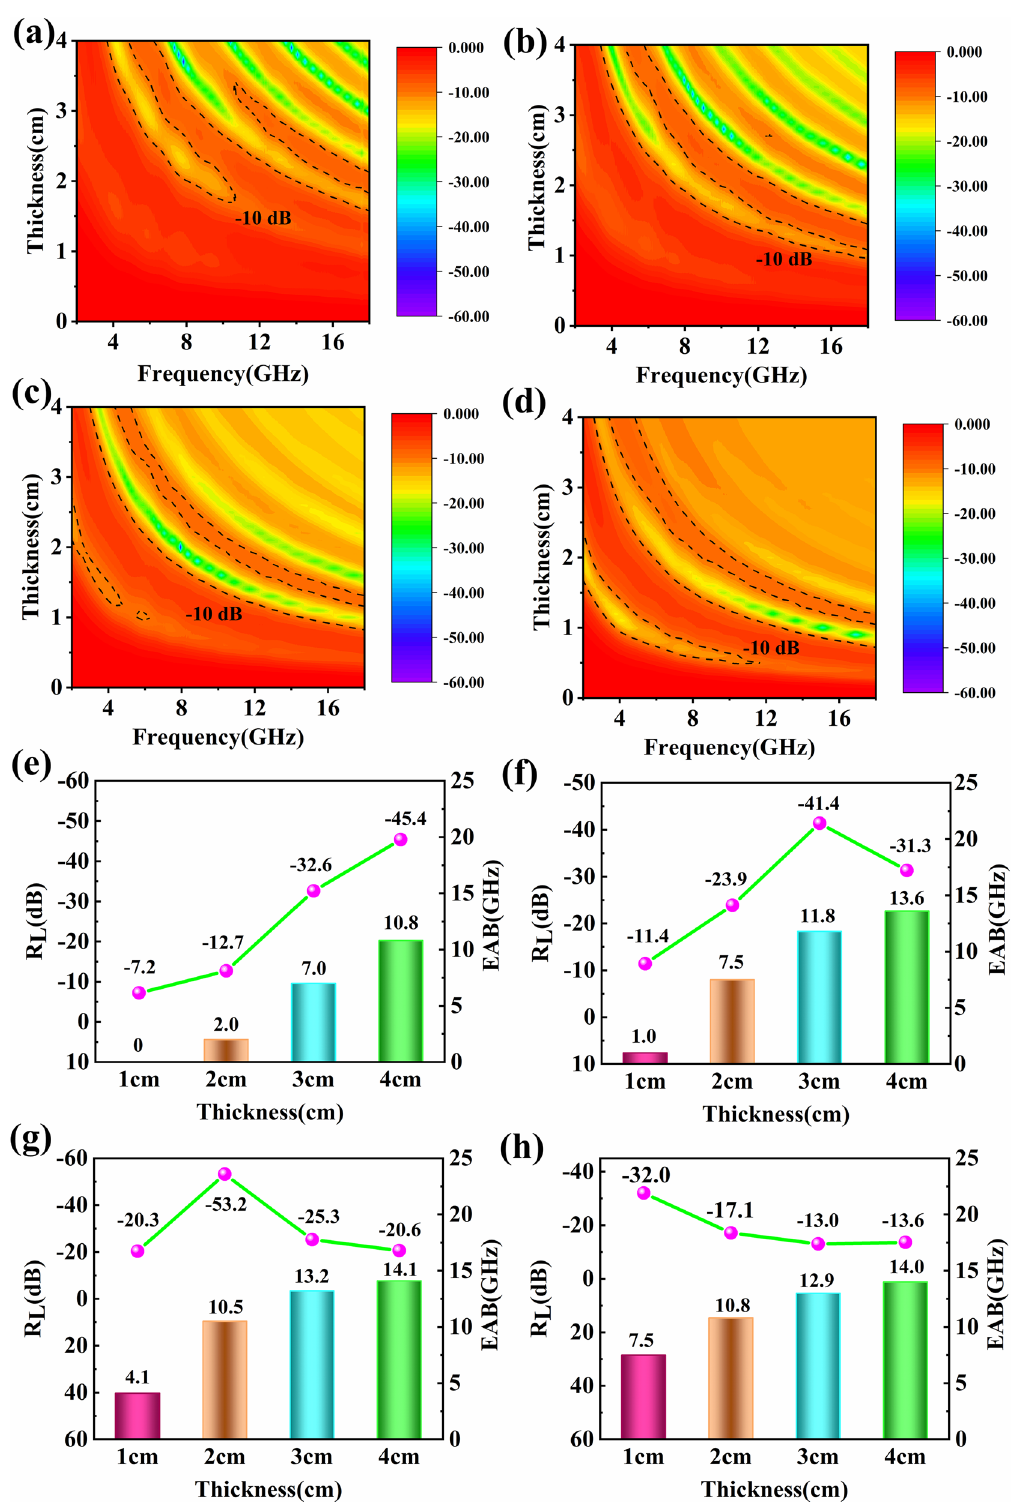
Fig. 2 Two-dimensional R L map of a CP-1, b CP-2, c CP-3, d CP-4, maximum reflection loss value and EAB at different thicknesses of e